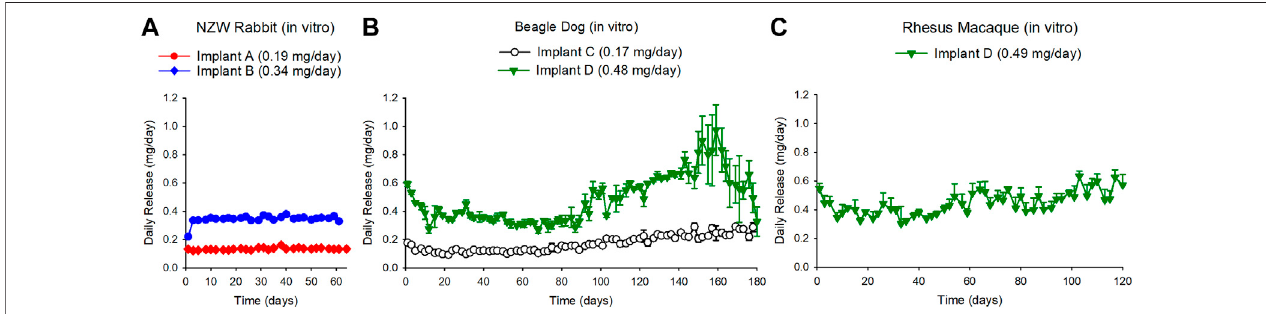
FIGURE2|(A) DailyreleaseratesofTAFfrom invitro implantsruninparallelwiththe invivo studyinNZWrabbitsresultedinTAFreleaserateof0.19+0.07 mg/day and 0.34 + 0.07 mg/day for the Implant A and the Implant B in the NZW rabbit corresponding groups, respectively. (B) Daily release rates of TAF from in vitro implants that were run in parallel with the in vivo study in beagle dogs resulted in a TAF release rate of 0.17 + 0.06 mg/day and 0.48 + 0.17 mg/day for the Implant C and the ImplantDbeagledogcorrespondinggroups,respectively. (C) DailyreleaseratesofTAFfrom invitro implantsthatwereruninparallelwiththe invivo studyinrhesus macaque resulted in a TAF release rate of 0.49 + 0.16 mg/day for Implant D. Each data point represents the average + standard